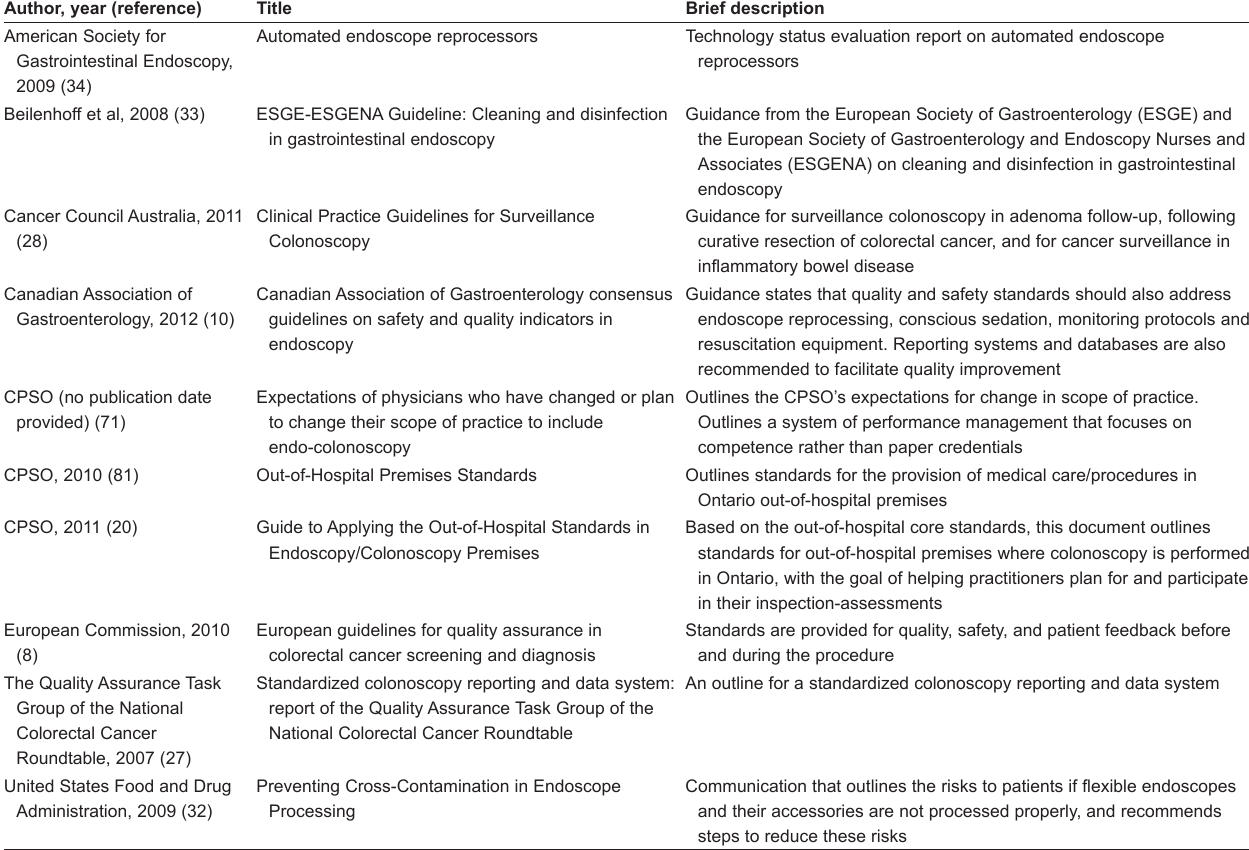
TAble 3 Guidance documents that addressed aspects of institutional standards for performance of